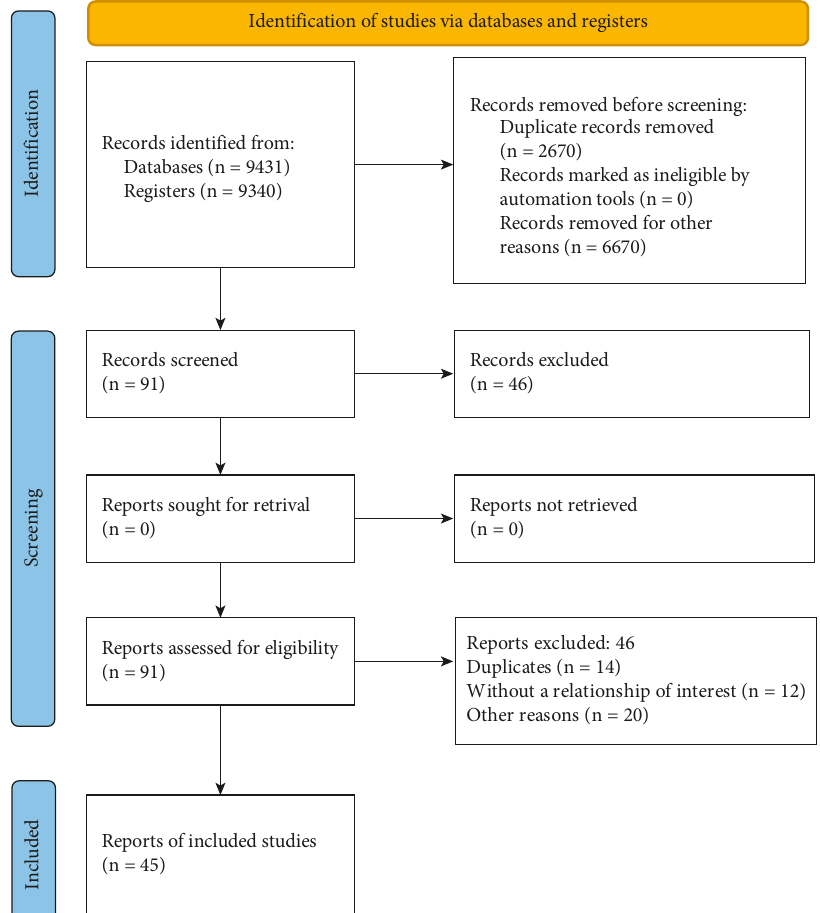
Figure 1: PRISMA 2020 flow